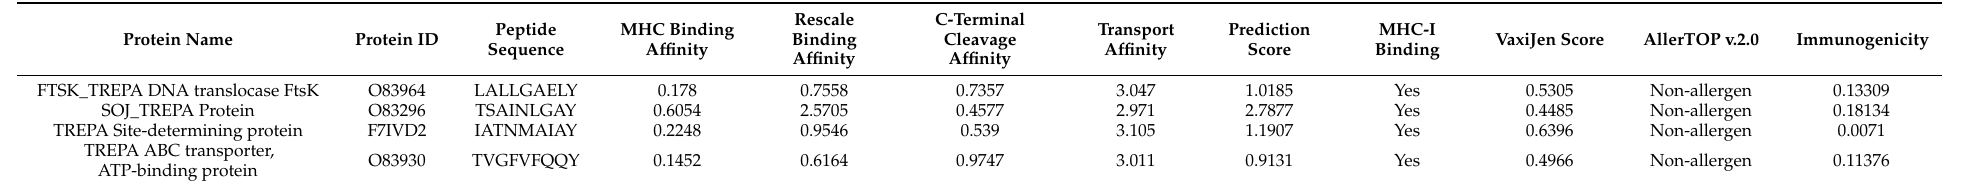
Table 2. Predicted linear cytotoxic T-lymphocyte epitopes, and its major histocompatibility complex class 1 (MHC-I) binding affinity with antigemicity score.